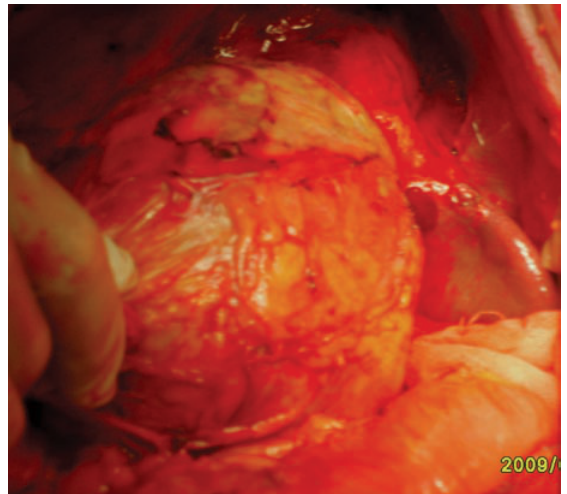
Figure 2. Intraoperative appearance of a round soft-tissue mass.